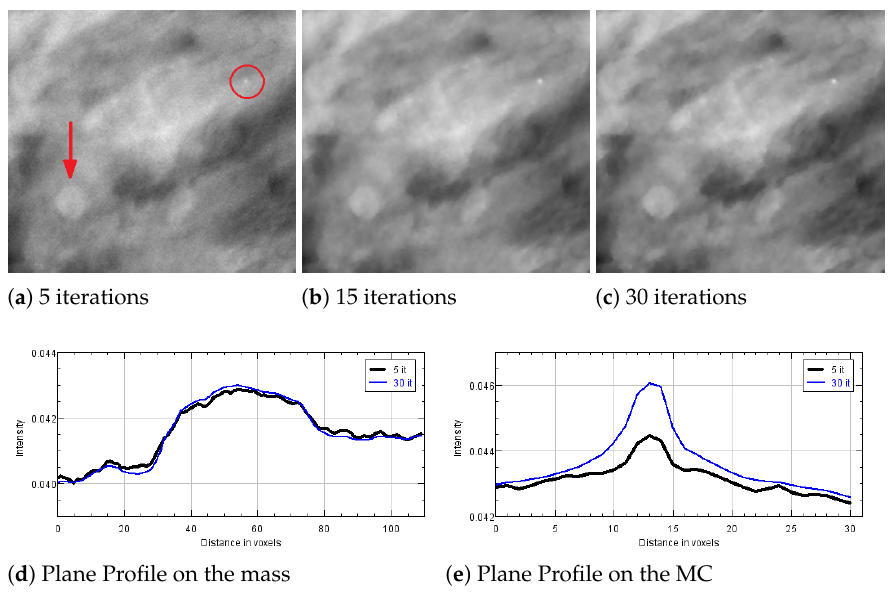
Figure 8. Results obtained after 5, 15 and 30 SGP iterations on a human breast data set. ( a – c ) Reconstructions of a 440 × 400 pixels region presenting both a spherical mass (pointed by the arrow) and a microcalficication (identified by the circle). ( d , e ) Plane profiles on the mass and on the microcalcification. In the plots: black line corresponds to 5 iterations and blue line to 30 iterations. Table 4. Valuexs of the of CNR and FWHM indices computed on the mass and the microcalcification observable in Figure 8a–c. CNR